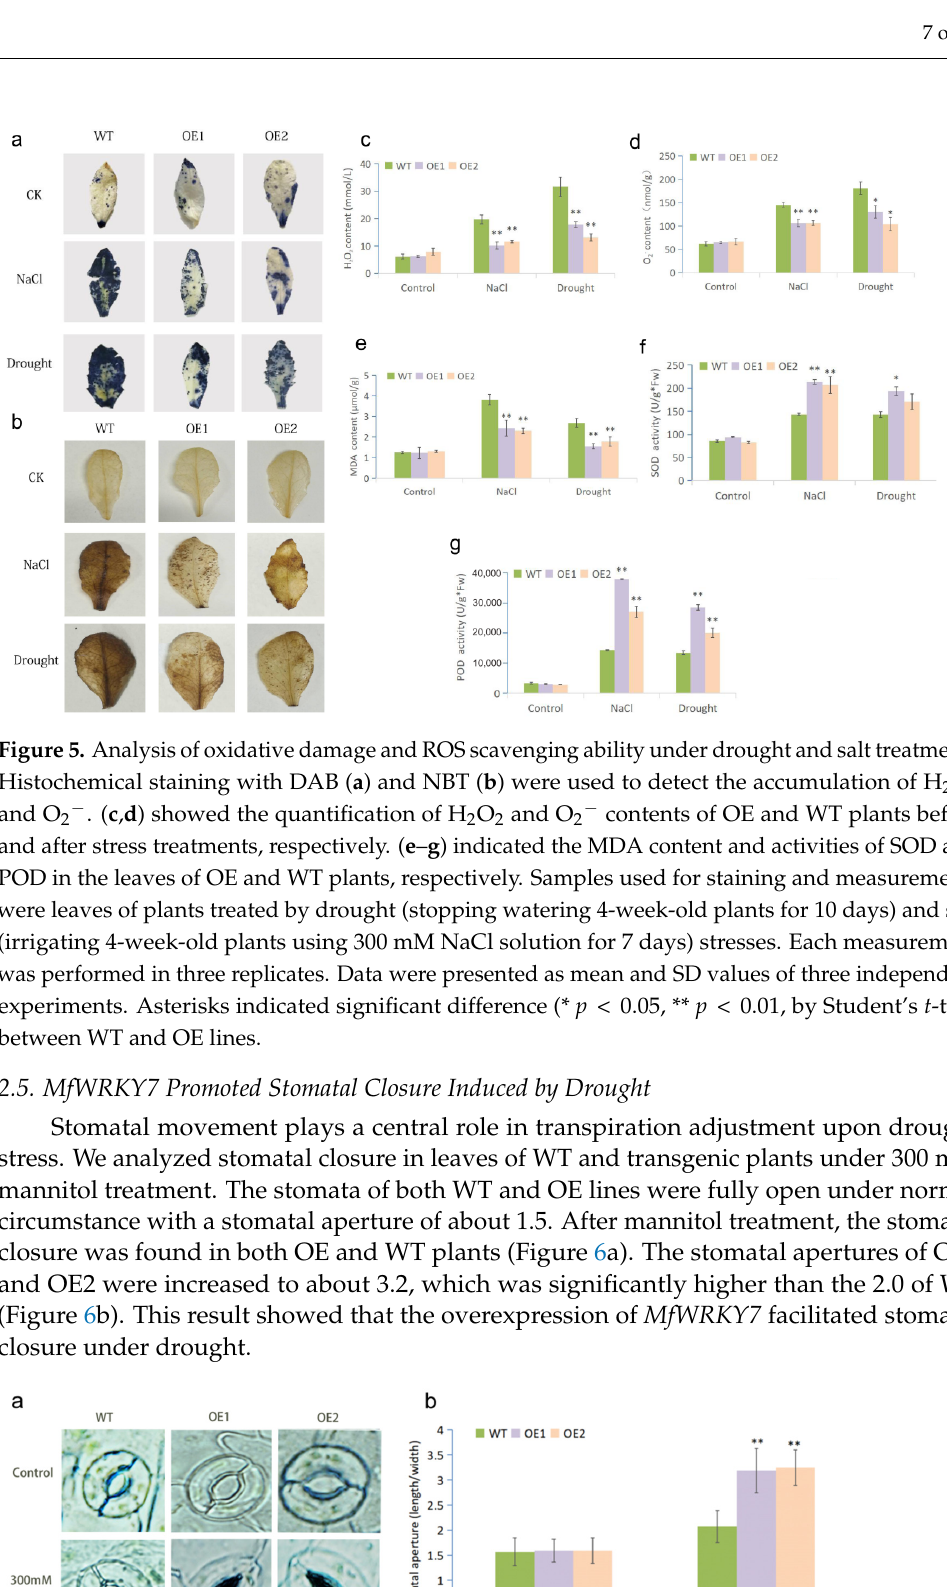
Figure 6. Measurements of stomatal aperture. ( a ) Microscopy observation of stomatal aperture of MfWRKY7 transgenic and WT plants in response to 300 mM mannitol. ( b ) Measurement of stomatal aperture with or without mannitol treatment. Data were presented as mean and SD values of three independent experiments. Asterisks indicated significant difference (** p < 0.01, by Student’s t -test) between WT and OE